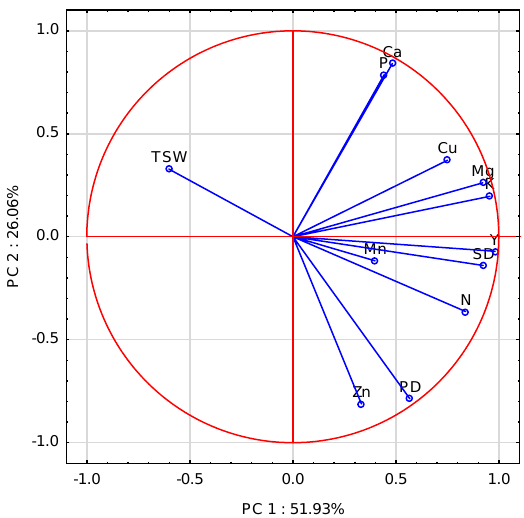
Figure 4. Score plot of WOSR components and nutrient accumulated in total WOSR biomass at harvest in PC1 and PC2 axes. Y—Yield, SD—Seed Density, PD—Pod Density, TSW—Thousand Seed Weight, N, P, K, Mg, Ca, Mn, Zn, Cu — nutrients.